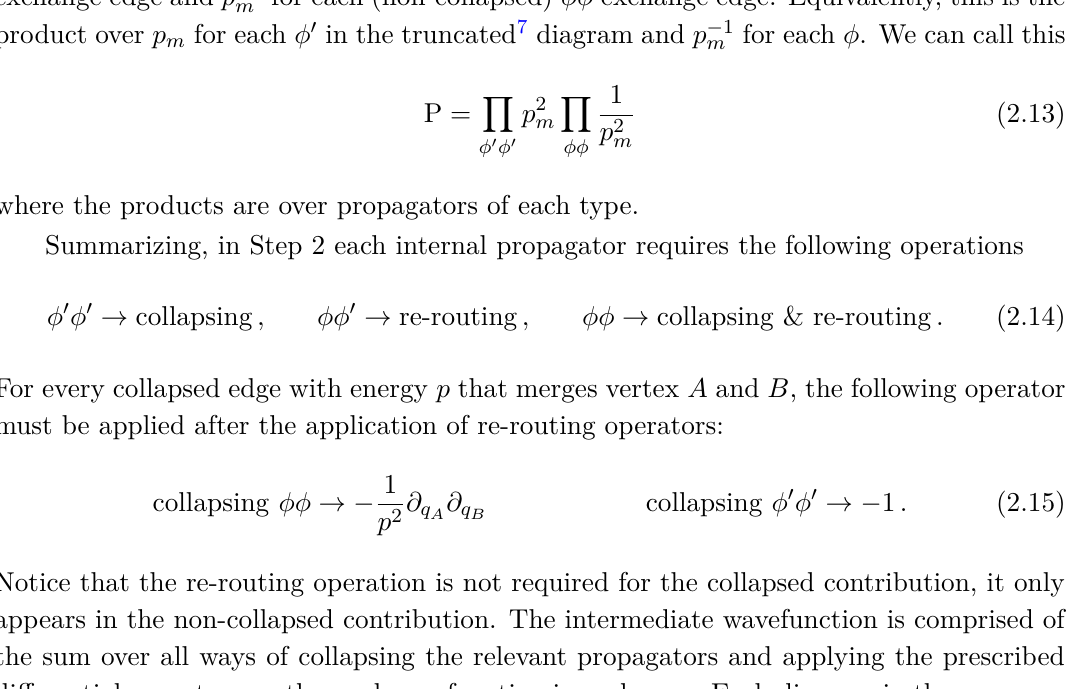
Figure 2 . For a half-edge φ the graphic defines flowing vertex side or opposite-vertex side. A choice of flow determines a differential operator summing over energies in G itself or in G including the R